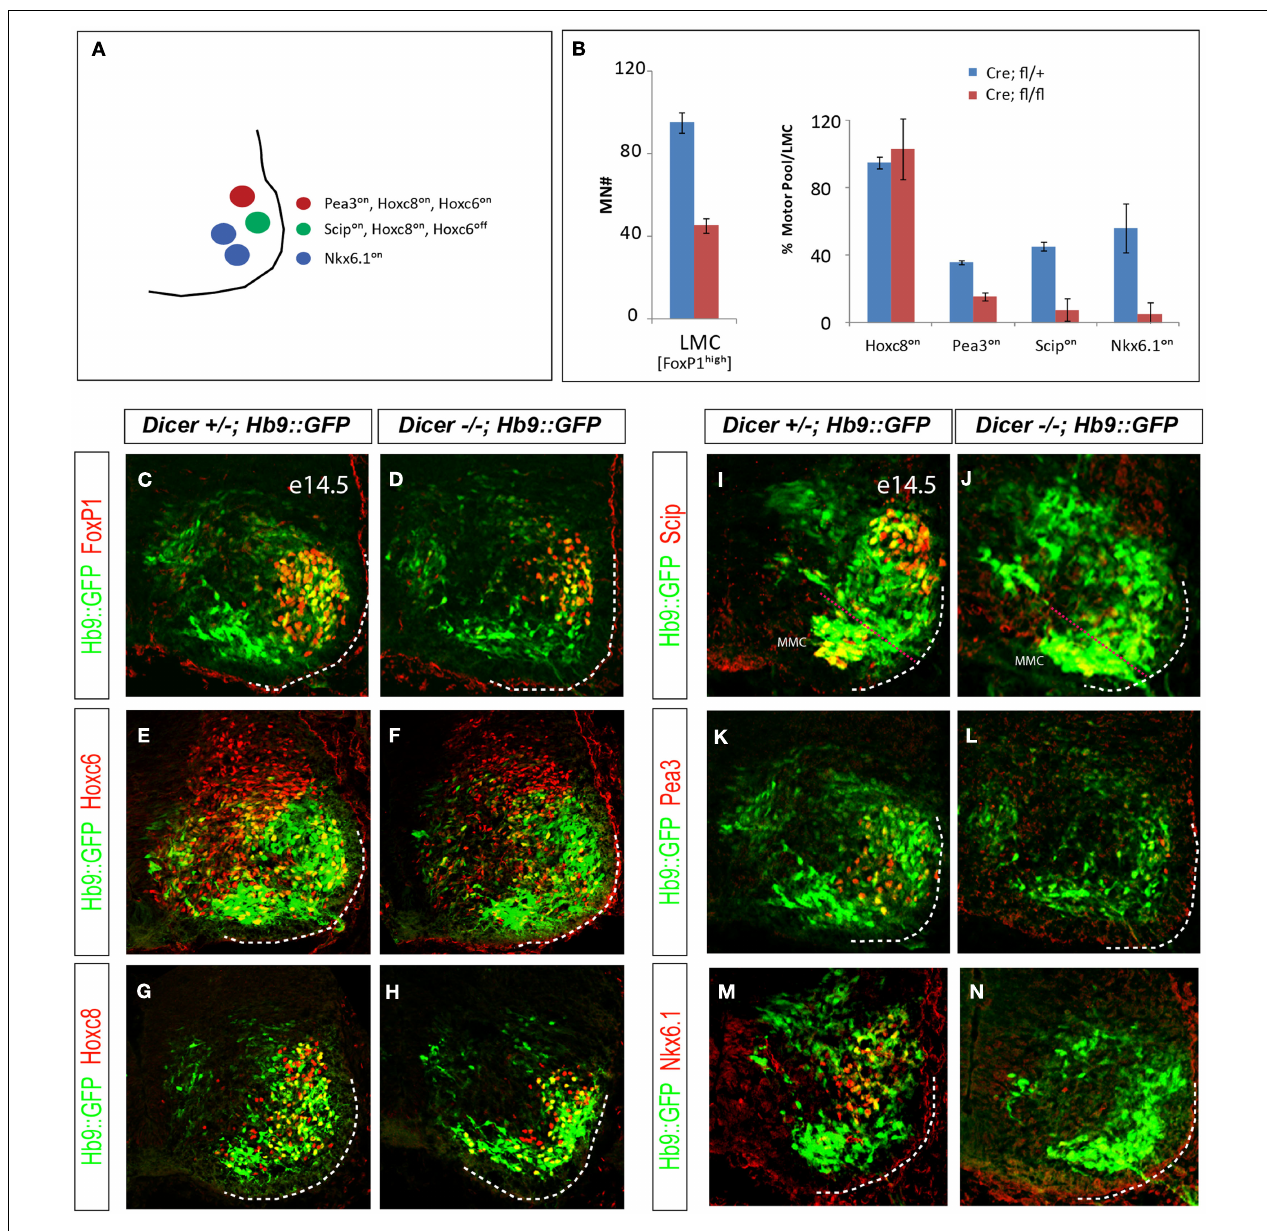
(C–H) Despite the reduction of LMC (FoxP1 high ) motor neuron number in the brachial spinal cord, the rostro-caudal patterning manifested by the expression of Hoxc6 and Hoxc8 transcription factors in the caudal brachial spinal cord is not affected in the at E14.5. Motor neurons are labeled by Hb9::GFP transgene. (I–N) The expression of all examined motor pool markers (Pea3 on , Scip on , or Nkx6.1 on ) is reduced in the conditional Dicer KO